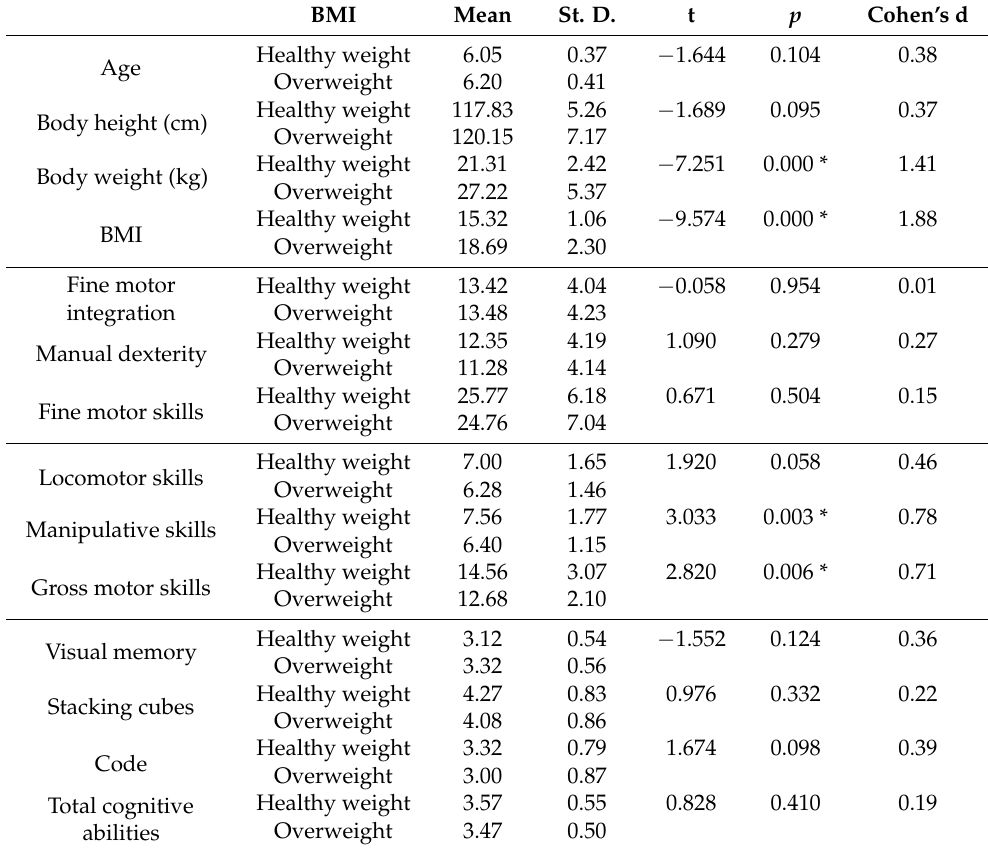
Table 2. Normal and Overweight Children differ in Motor and Cognitive Skills. BMI Mean St.